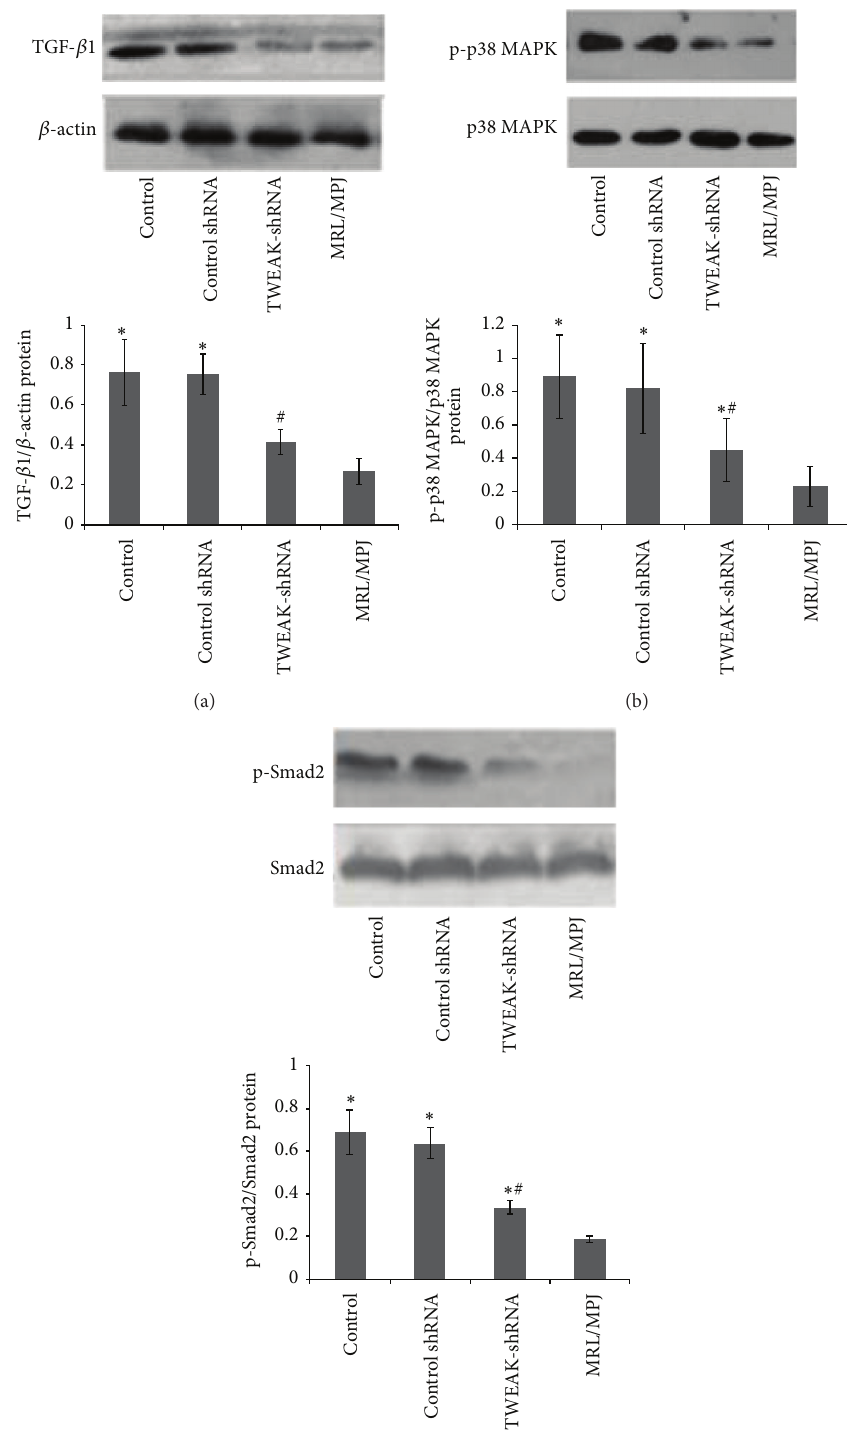
Figure 5: Effects of LV-TWEAK-shRNA treatment on expressions of TGF- 𝛽 1, p-p38 MAPK, and p-Smad2 proteins in kidneys of MRL/lpr mice. Total lysates of kidneys were collected for Western blotting to measure TGF- 𝛽 1 (a), p-p38 MAPK (b), and p-Smad2 (c) protein expressionsinMRL/lprmice.Therepresentativeexperimentswerepresentedatthetop.TheratiosofTWEAK/ 𝛽 -actinIOD,p-p38MAPK/p38 MAPK IOD, and p-Smad2/Smad2 IOD were shown at the bottom. Control: MRL/lpr mice treated with PBS; Control shRNA: MRL/lpr mice treated with LV-Control shRNA; TWEAK-shRNA: MRL/lpr mice treated with LV-TWEAK-shRNA; and MRL/MPJ: MRL/MPJ mice as normal control. The error bars represent the standard deviation. # 𝑝 < 0.01 versus control MRL/lpr mice and ∗ 𝑝 < 0.01 versus MRL/MPJ